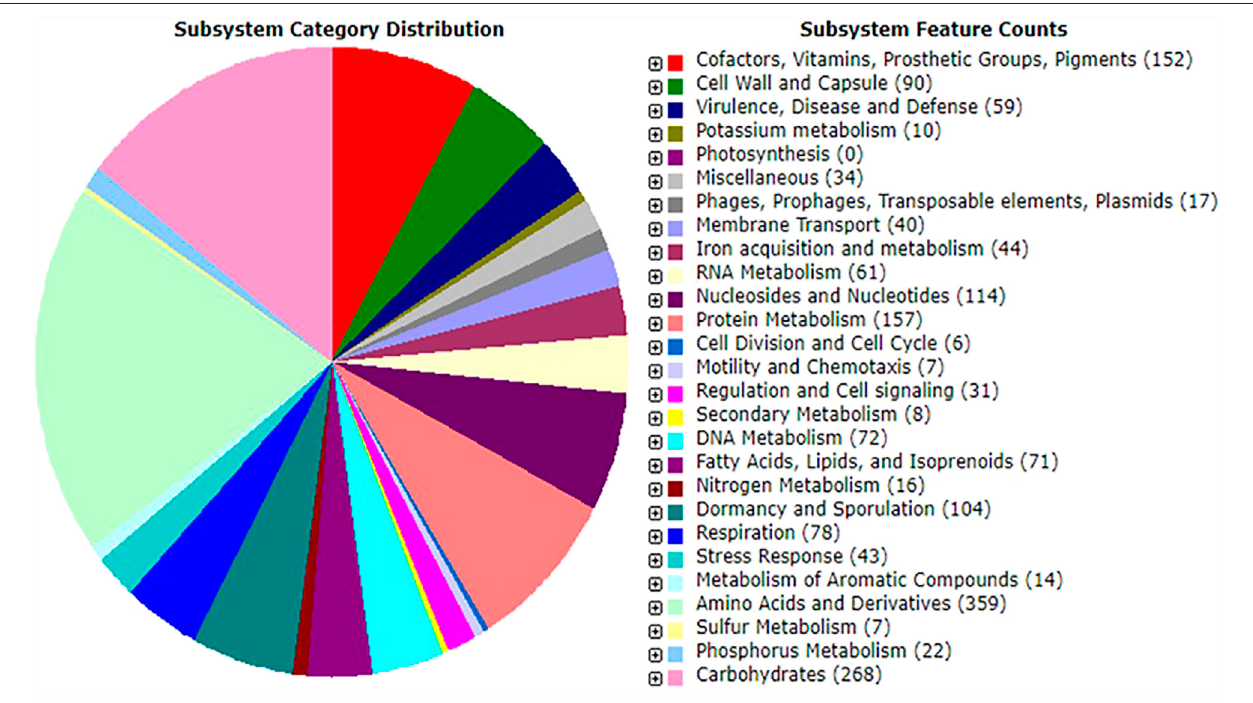
FIGURE 1 | An overview of subsystem categories assigned to genes predicted in genome of Bacillus paranthracis strain MHSD3 based on RAST server.